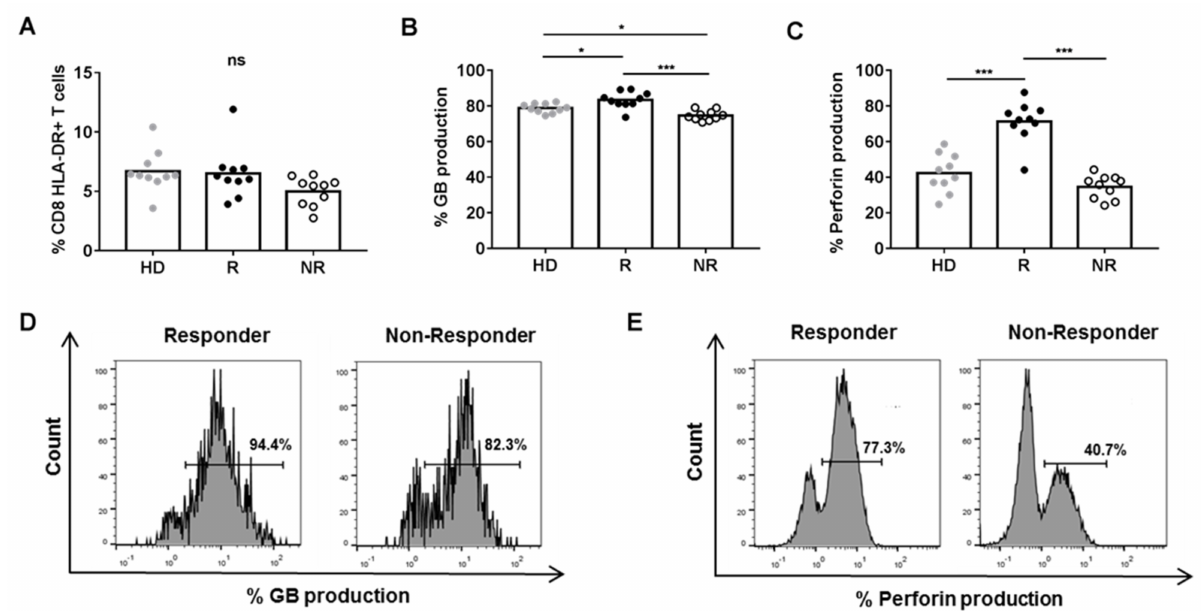
Figure 2. Phenotype and cytotoxic function of CD8+ HLA-DR+ T cells after a 72 h-culture of HD ( n = 10) PBMCs with 25% plasma from R ( n = 10) and NR ( n = 10) BC patients. ( A ) Percentage of CD8+ HLA-DR+ T cells ( B ) Percentage of CD8+ HLA-DR+ T cells producing granzyme B (GB). ( C ) Percentage of CD8+ HLA-DR+ T cells producing perforin. ( D ) Representation of a flow cytometry analysis of granzyme B expression and, ( E ) perforin expression in cultures with plasma from R and NR patients. * p < 05; *** p < 0.001.